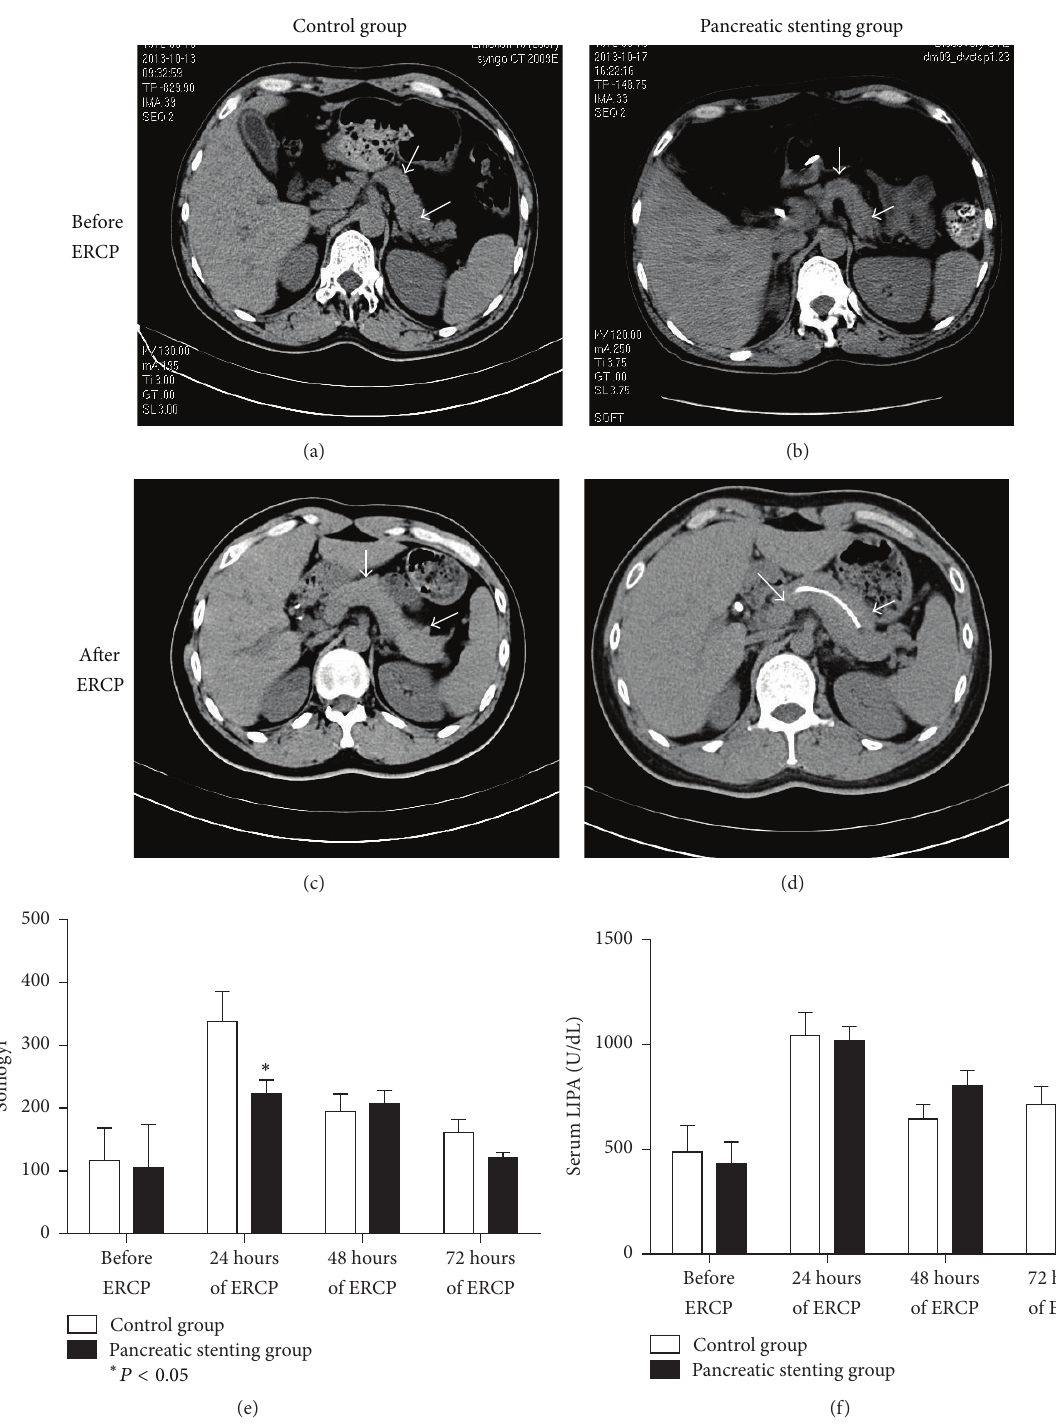
Figure 2: Occurrence and resolution of PEP: (a–d) representative computed tomography scan of the experimental (with pancreatic duct stenting) and control groups (without stenting) before and after ERCP showing obvious PEP (as indicated by the white arrow) in the control group; serum levels of (e) amylase and (f) lipase before ERCP and 24 h, 48 h, and 72 h after